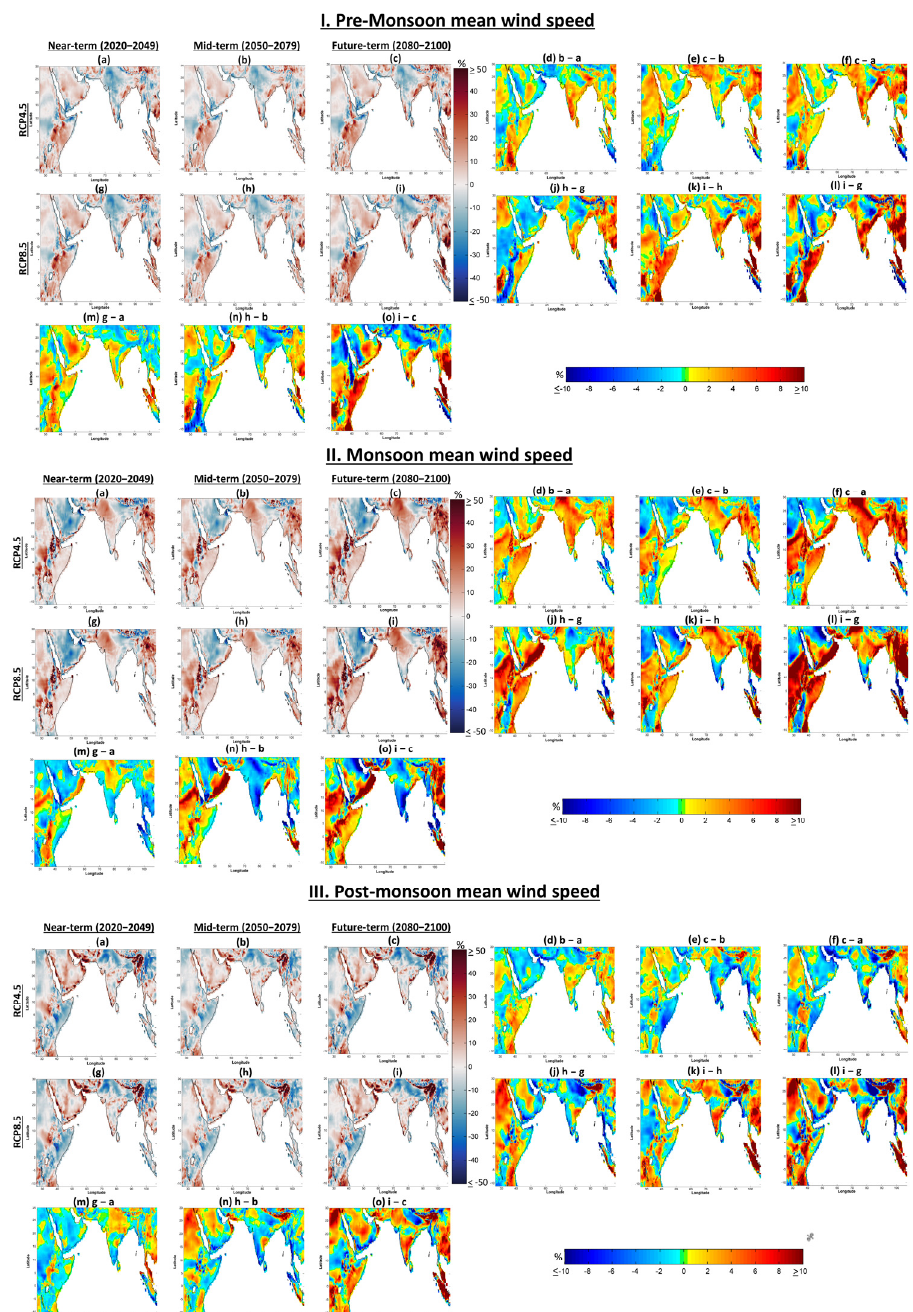
Figure 14. As in Figure 11, but for ( I ) pre-monsoon (February–May), ( II ) monsoon (June–September), and ( III ) post-monsoon (October–January) mean wind speed over land region of South Asian domain, and the percentage change is calculated based on projections of ACCESS1.0. Over the northwestern part of India, the weakening of future WS is observed in pre and post ‐ monsoon season, whereas strengthening of future WS is observed in monsoon season. Similarly, over Saudi Arabia, weakening of future WS in monsoon season and strengthening in pre and post ‐ monsoon seasons is observed (Figure 14). In both RCP sce ‐ narios, the average increase in percentage change of future ‐ term mean WS over land is higher for monsoon season, followed by post ‐ monsoon and pre ‐ monsoon. The 203.69%